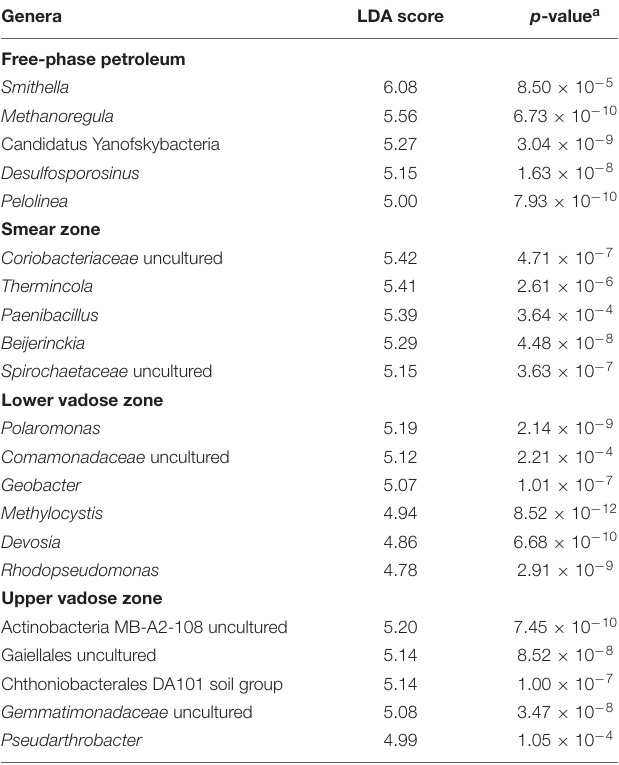
TABLE 1 | Top genera identified as biomarkers for the four different zones based on Linear Discriminant Analysis (LDA) scores. Genera LDA score p -value